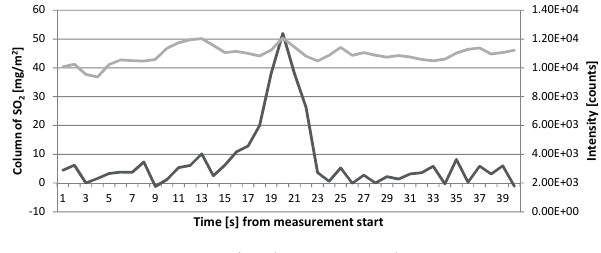
Fig. 7. Optical measurement of SO 2 for a flight transect across the plume of a large ferry outside Rotterdam harbour on 25 Septem- ber 2009 at 15:00LT (local time). The noise level is 2.7mgm 2 . The intensity at 311nm is